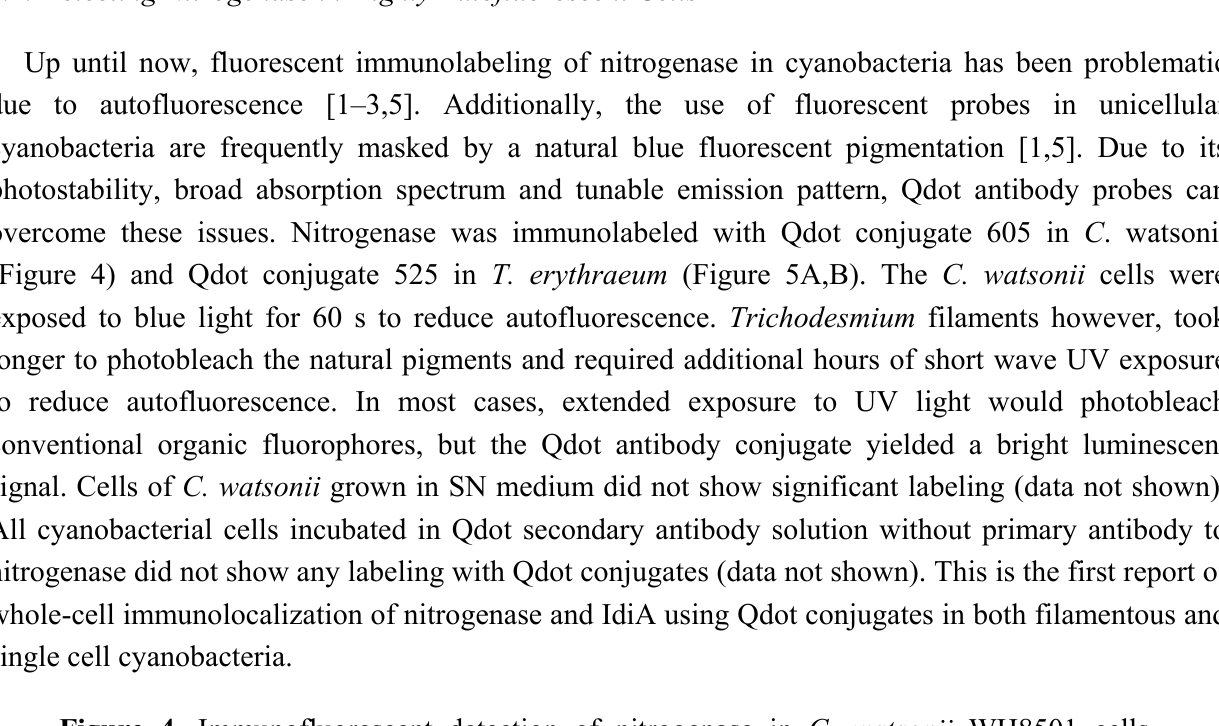
Figure 4. Immunofluorescent detection of nitrogenase in C. watsonii WH8501 cells. Binding of the nitrogenase antibody to cellular structures was visualized by subsequent incubation with the Qdot 605 anti-rabbit IgG antibody. Photograph captured at 1000X magnification after 60 s exposure to blue